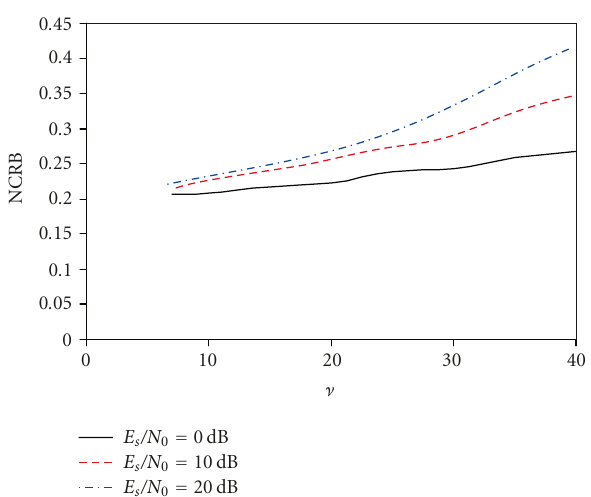
Figure 7: GCRB and MSE, N = 1024, M = 40, ν =